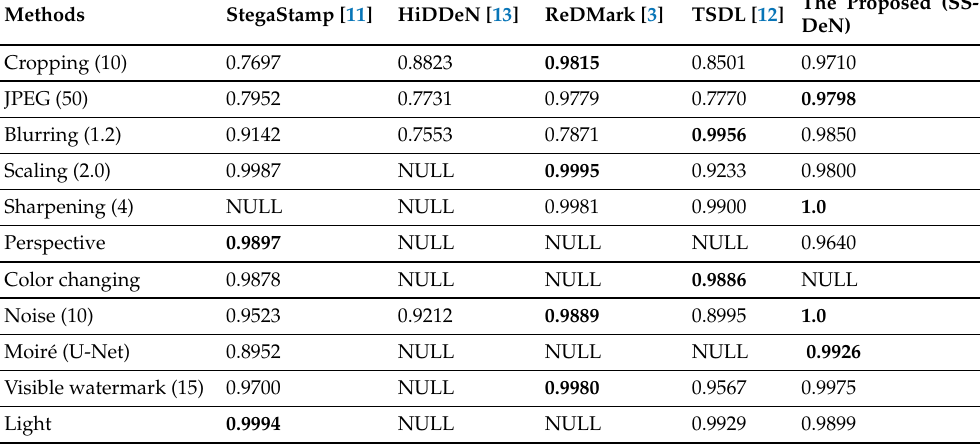
Table 6. Comparing the extracted watermark of the proposed algorithm and previous methods in terms of